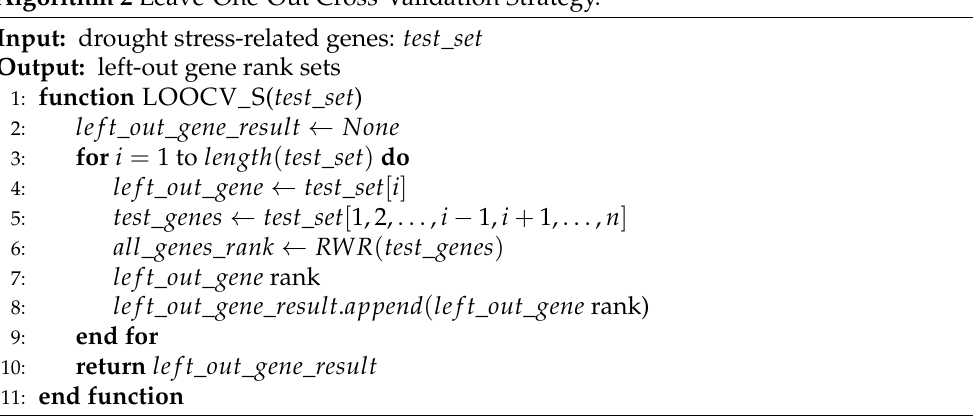
Algorithm 2 Leave-One-Out Cross-Validation